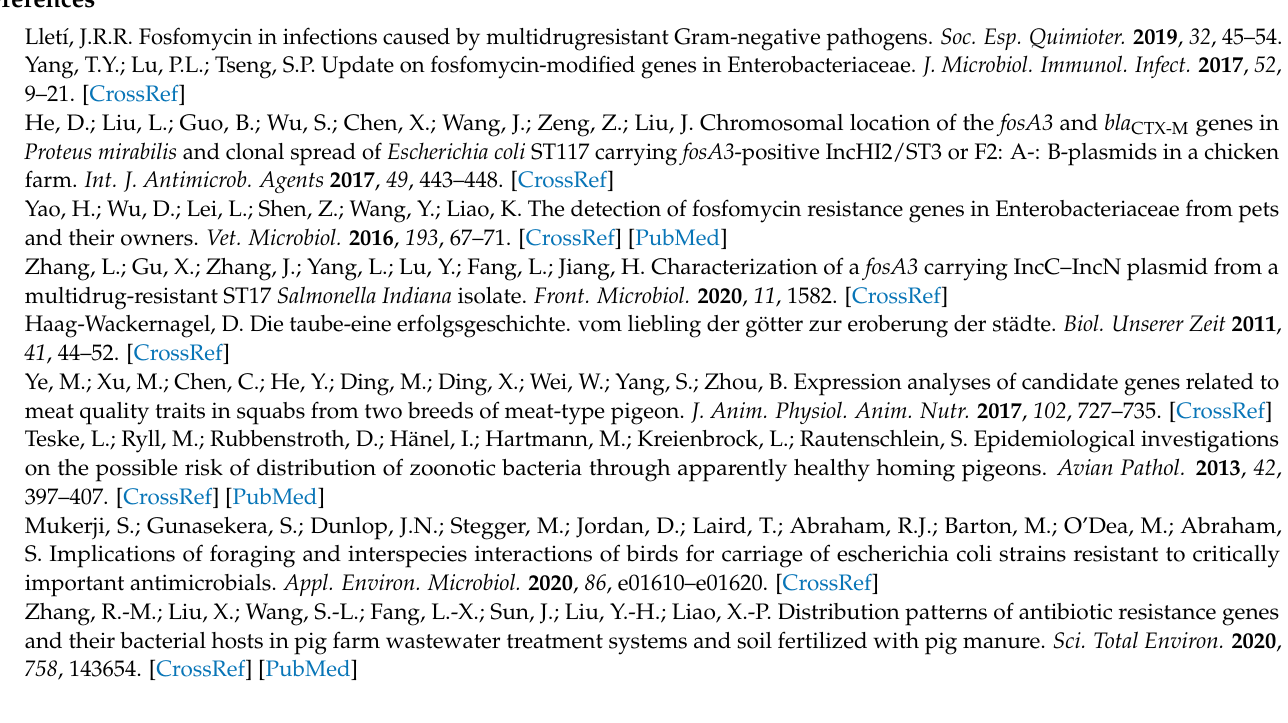
fosA3-carrying plasmids on different sizes. Figure S2: Phylogenetic analysis of the fosA3 positive E. coli from public repository and current study Table S1: Sample collection, strain identification and MIC